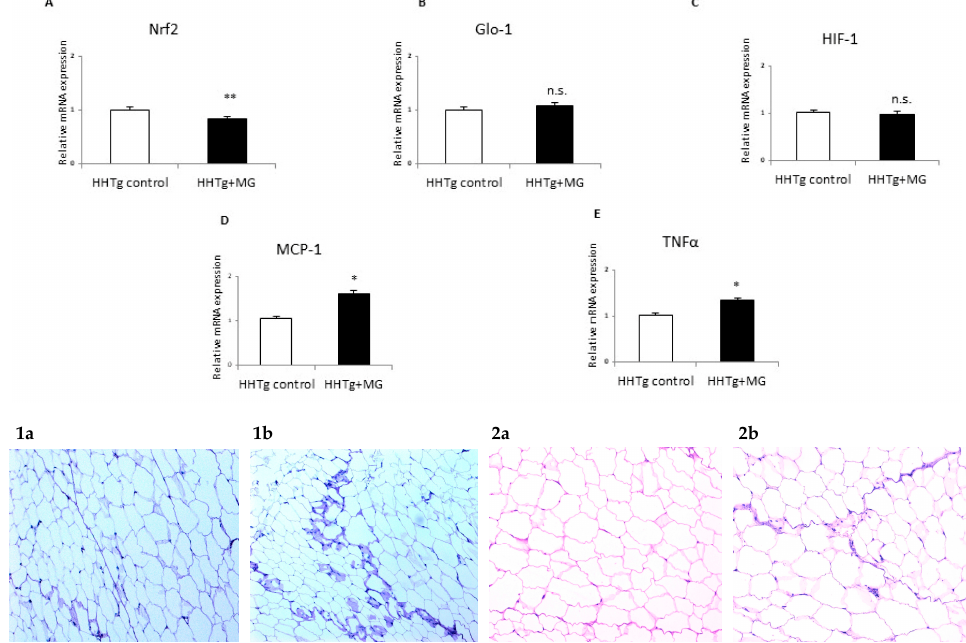
Figure 2. Effects of methylglyoxal (MG) treatment on dicarbonyl stress, inflammation and hypoxia parameters in visceral adipose tissue. Relative mRNA expression of Nrf2 (Panel A ), Glo-1 (Panel B ), Hif-1 (Panel C ), MCP-1 (Panel D ) and TNF α (Panel E ) in visceral adipose tissue of MG-treated rats compared to HHTg (hereditary hypetriglyceridaemic) control rats; Nrf2—nuclear factor erythroid 2-related